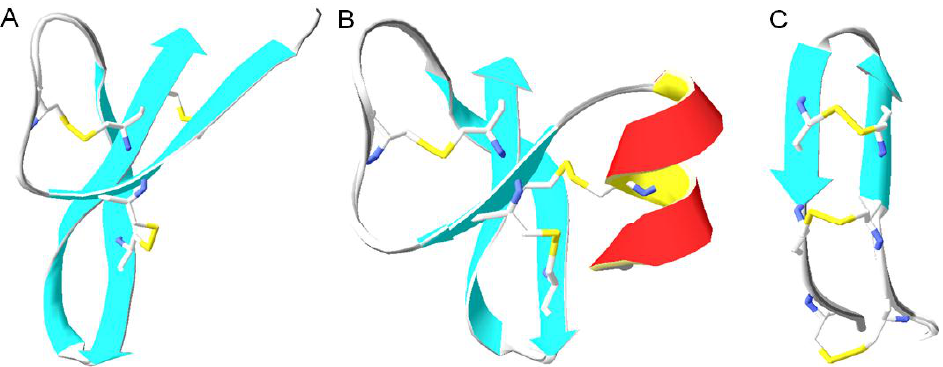
Figure 2. Three structural classes of defensines. The PDB codes are all indicated, in addition to the primary sequence with the disulfide bridges indicated with numbers in subscript ( A ) Human alpha-defensin-6 (PDB code 1ZMQ) AFTC 1 HC 2 RRSC 3 YSTEYSYGTC 2 TVMGINHRFC 3 C 1 L [31]; ( B ) Human